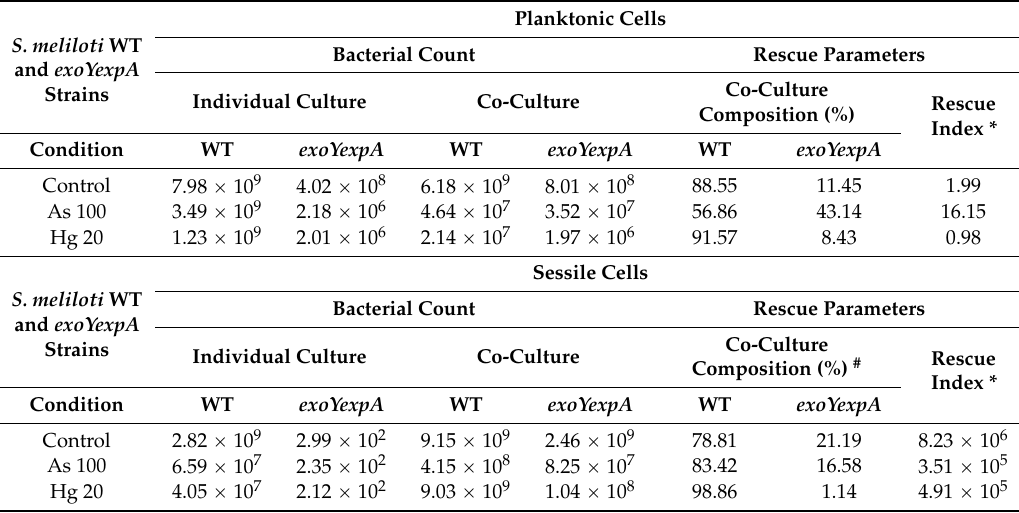
Table 3. Planktonic and sessile cell count of individual and co-culture S. meliloti WT and exoYexpA